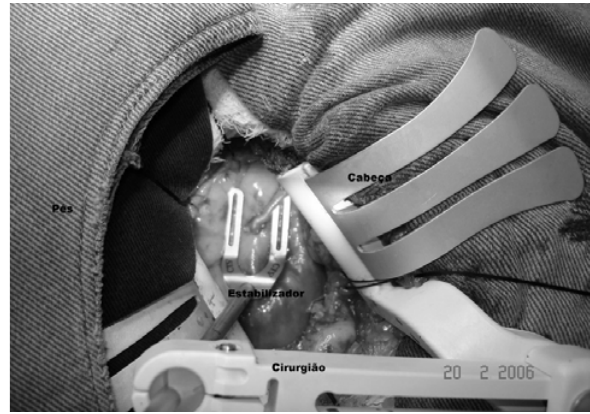
Fig. 3 - Anastomose com fio 7-0 posicionada sob dispositivo estabilizador